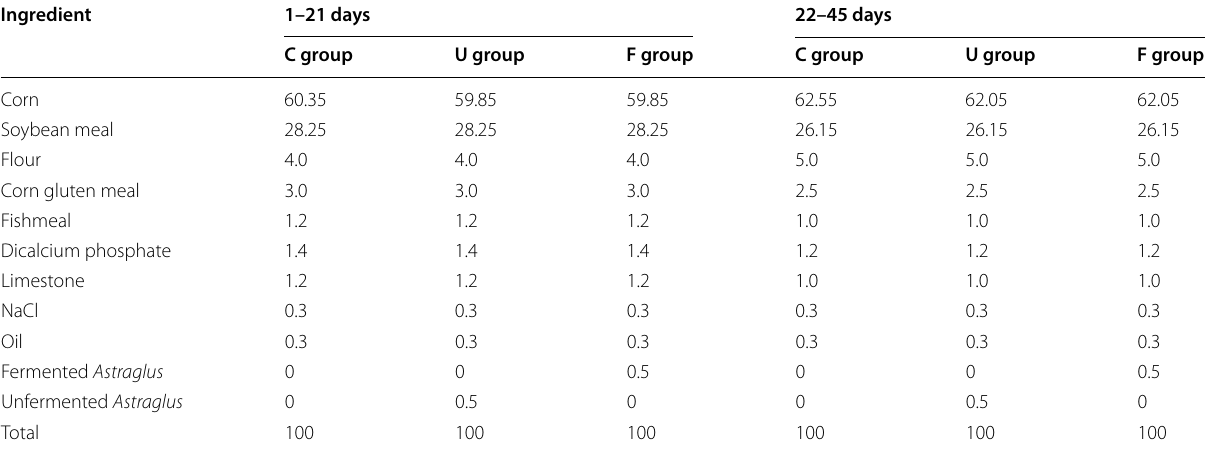
C group basal diet, U group basal diet